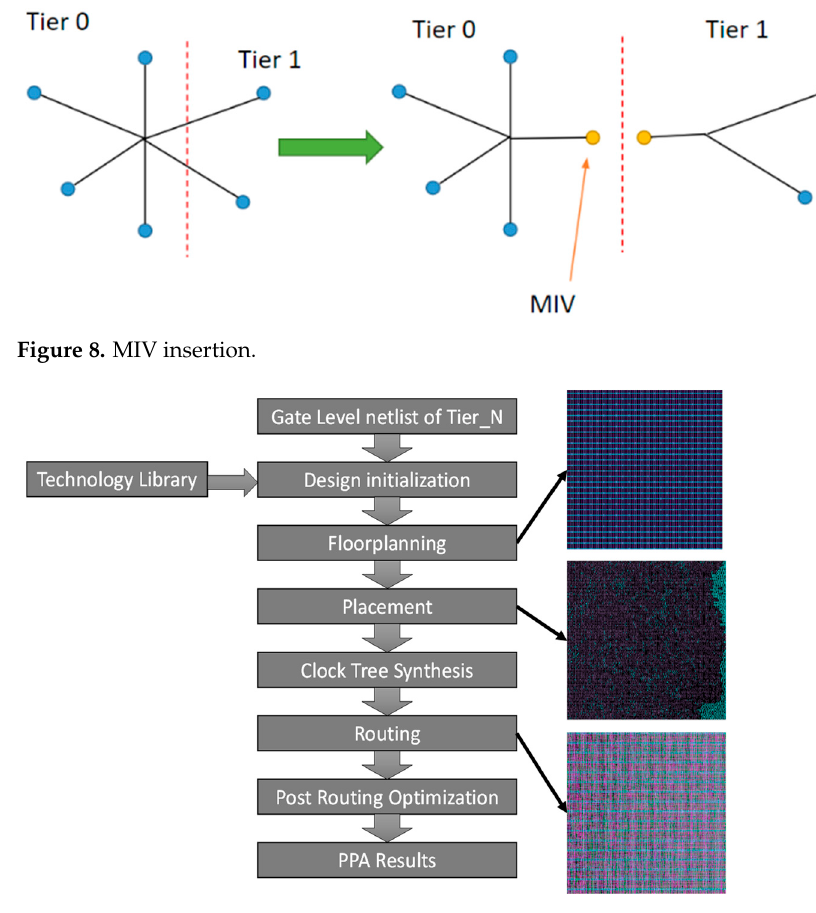
Figure 9. P&R design flow.